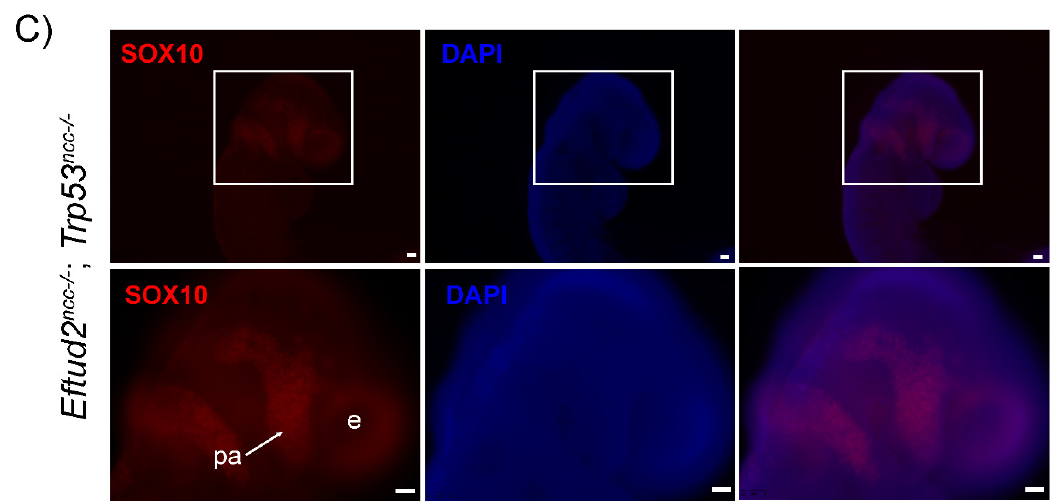
Figure 3. SOX10 expression is higher in Eftud2 ncc − / − ; Trp53 ncc − / − embryos than in Eftud2 ncc − / − and similar to controls, at E9.0. Representative images of the head of embryos after wholemount immunofluorescence staining with an antibody to SOX10 (red) or with DAPI (blue) in ( A ) con- trol ( n = 4), ( B ) Eftud2 ncc − / − ; Trp53 ncc+/+ ( n = 4), and ( C ) Eftud2 ncc − / − ; Trp53 ncc − / − embryos ( n = 4). (Genotypes of control embryos included Eftud2 loxp/ − ; Trp53 loxp/+ or Eftud2 loxp/+ ; Trp53 loxp/loxp ). ( A ) In the control embryos, SOX10 is present in post-migratory neural crest cells in and around the eye and in the pharyngeal arches. ( B ) Reduced SOX10 staining is seen in Eftud2 ncc − / − ; Trp53 ncc+/+ em- bryos. ( C ) In Eftud2 ncc − / − ; Trp53 ncc − / − embryos staining for SOX10 is similar to that seen in controls. Scale bar = 50 µ m. e = eye, pa = pharyngeal